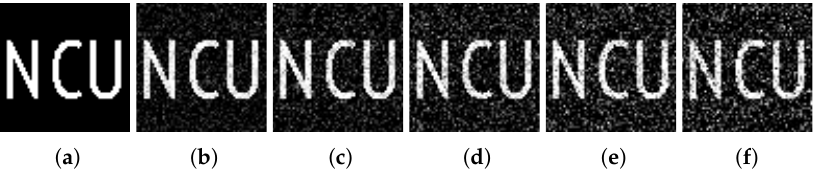
Figure 9. Image added Gaussian noise with a mean of 0 and variance of ( a ) 0, ( b ) 0.02, ( c ) 0.04, ( d ) 0.06, ( e ) 0.08, and ( f ) 0.1. The resolution of the images are all 64 × 64.